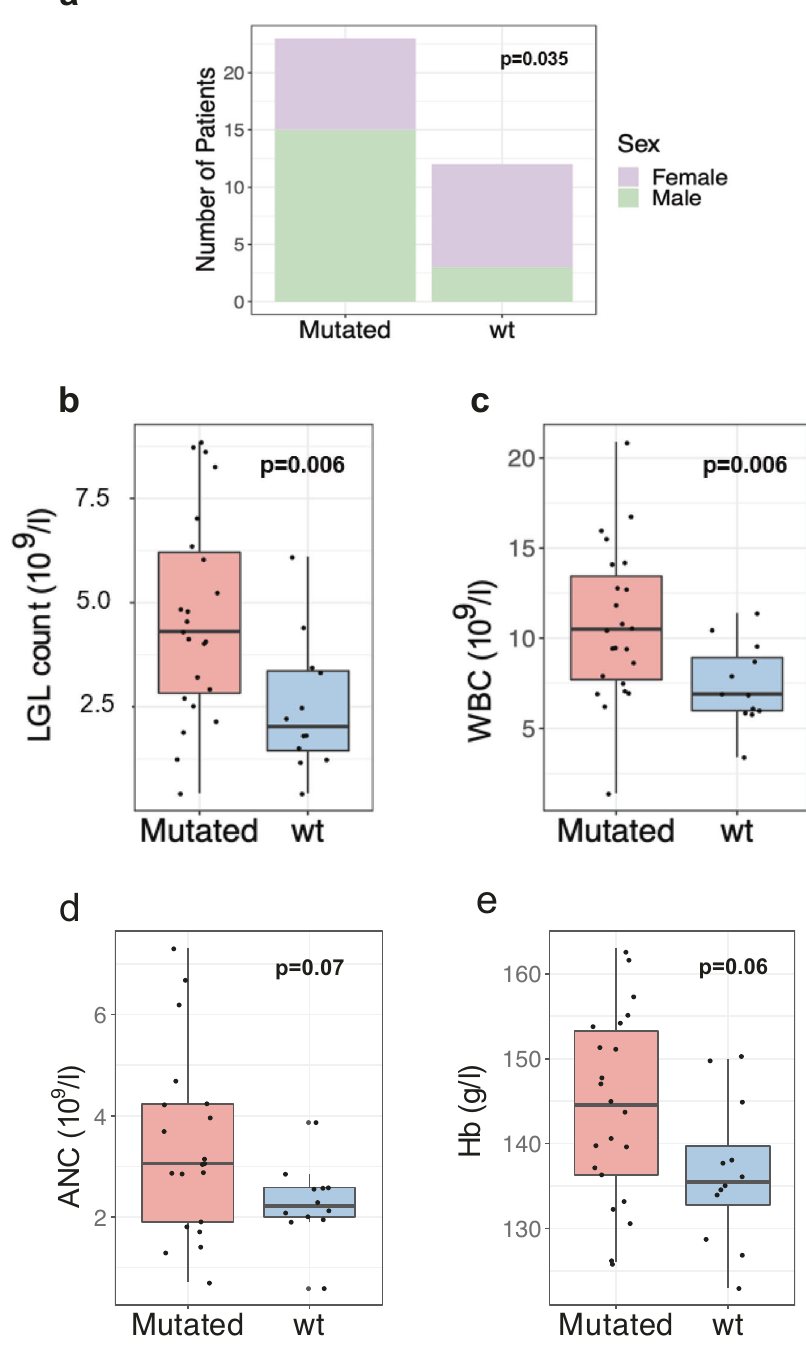
Fig. 2 Most relevant clinical features associated with STAT5B mutations. Box and bar plots of the clinical features in STAT5B mutated and wild-type patients: a Sex, b LGL count, c WBC, d ANC, e Hb All clinical features were analyzed with Mann – Whitney U -test except for sex prevalence which was analyzed with Fisher ’ s exact test. WBC white blood cells, LGL large granular lymphocytes, ANC absolute neutrophil count, Hb hemoglobin, wt